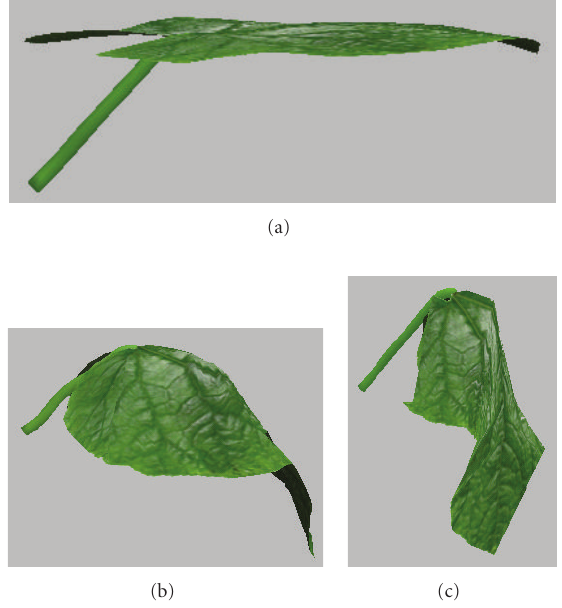
Figure 6: Simulated shapes of wilting cucumber leaf: (a) initial shape, (b) medium wilting, and (c) acute